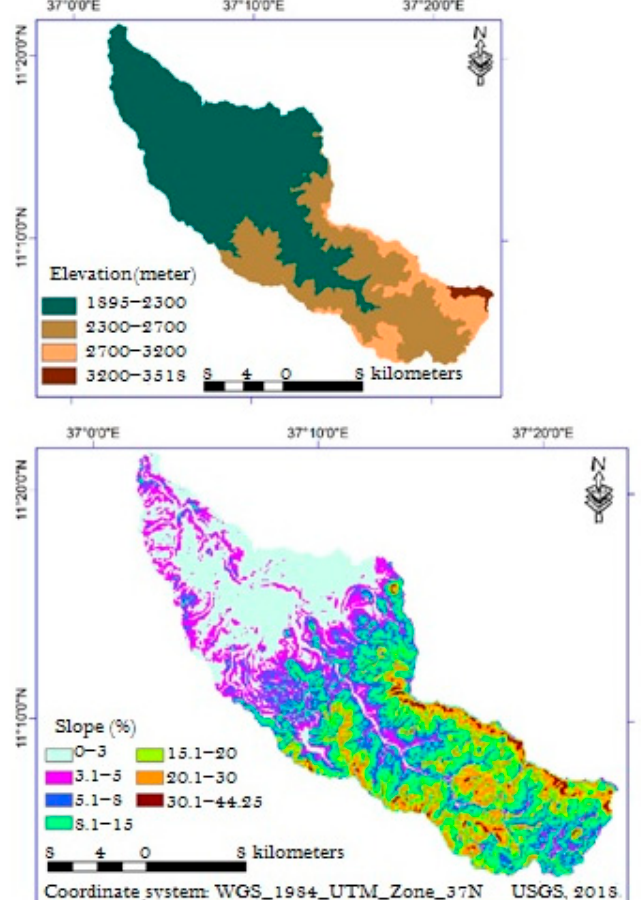
Figure 2. Elevation (m) and slope (%) classes of the Jema watershed.